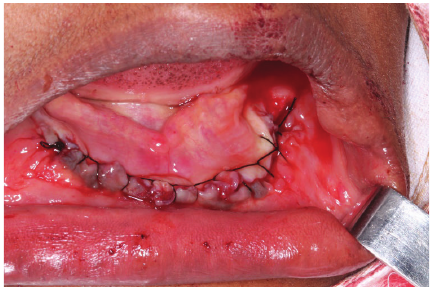
Figure 3: Surgical access to the injured area and the removal of all lower teeth.